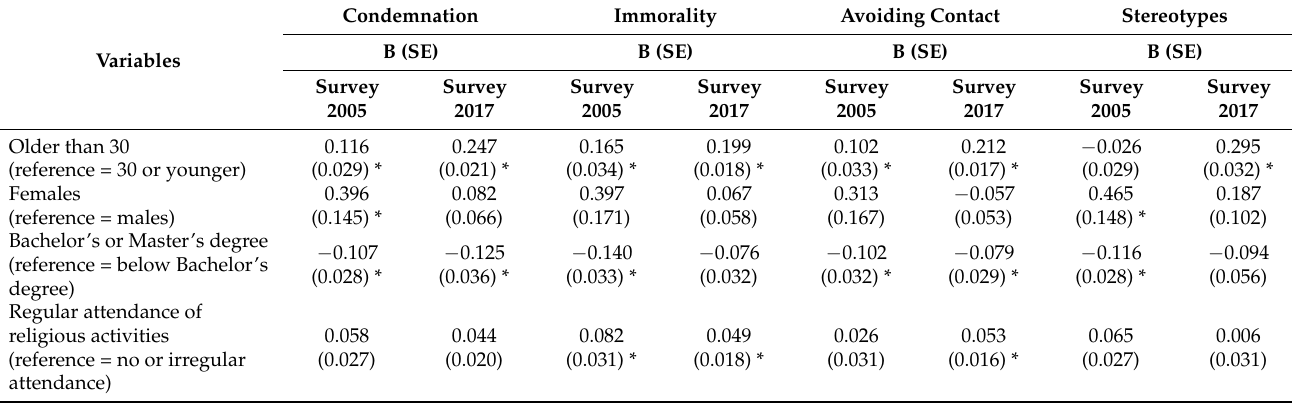
Table 3. Factors related to attitudes toward homosexuality in Survey 2005 and Survey 2017: multiple regression analysis a .